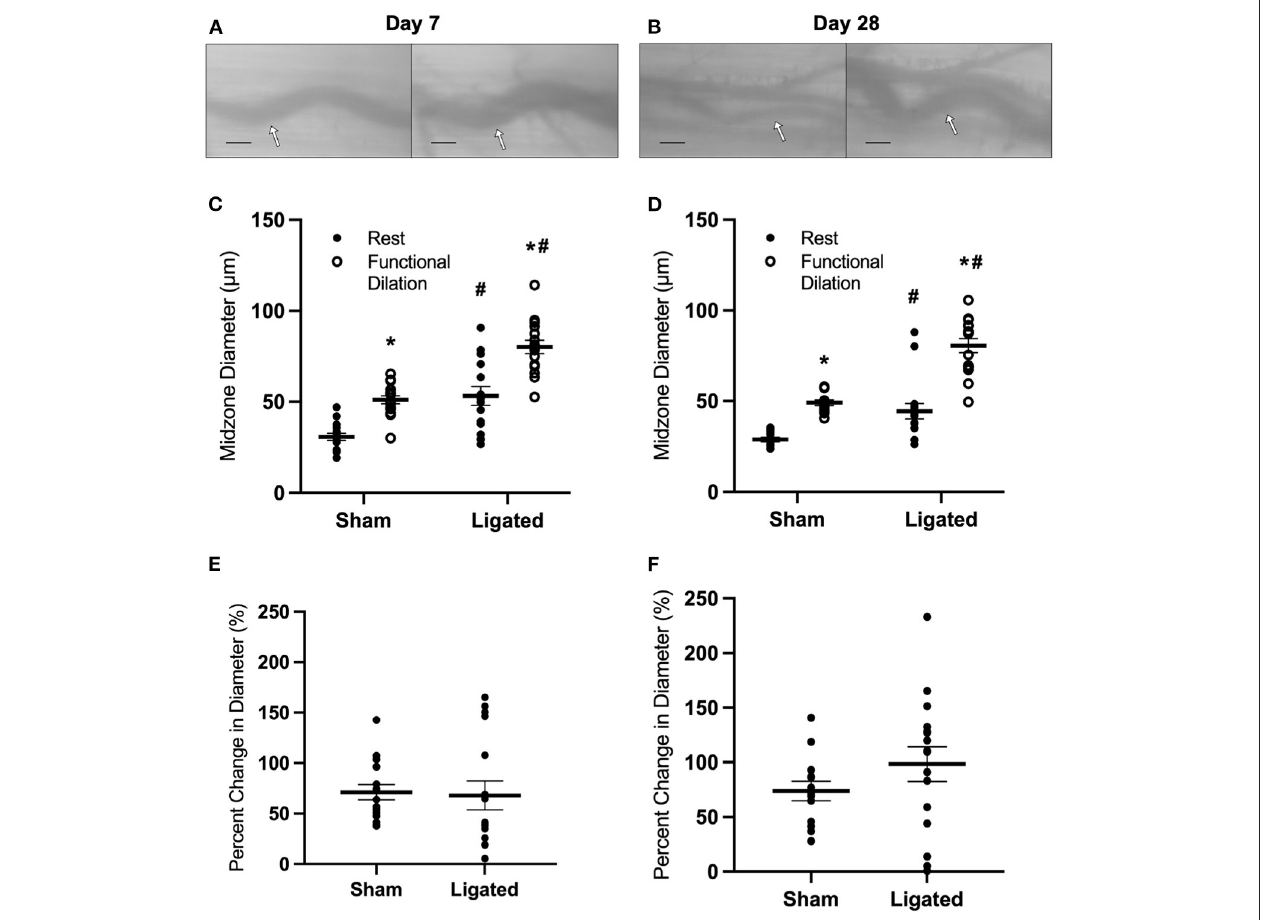
FIGURE 2 | Collateral functional vasodilation is improved with voluntary exercise. Collateral vessels were observed at the collateral midzone by intravital microscopy with transillumination at 7 days (A) or 28 days (B) post-femoral artery ligation in the left mouse hindlimb at rest (left) and following functional vasodilation (right); arrow indicates the enlarged collateral arteriole and scale bar represents 100 µ m. At each time point, the gracilis muscles of C57Bl/6 mice ( n = 16, 8 male and 8 female, each at day 7 and day 28) were stimulated with tungsten microelectrodes and a stimulus isolator. At day 7, resting diameter in the enlarged collateral was decreased in mice that performed voluntary exercise (C) , resulting in increased vascular reactivity; resting diameter was similarly low at day 28 (D) . Therefore, vascular reactivity was not different between enlarged and native collaterals of mice that performed voluntary exercise at both day 7 and day 28 (E,F) . * p < 0.05 vs. resting, # p < 0.05 vs.